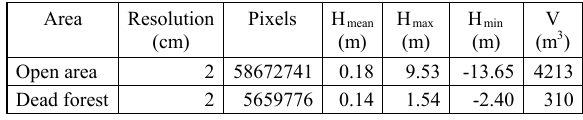
Table 5. Snow volume calculations based on UAV